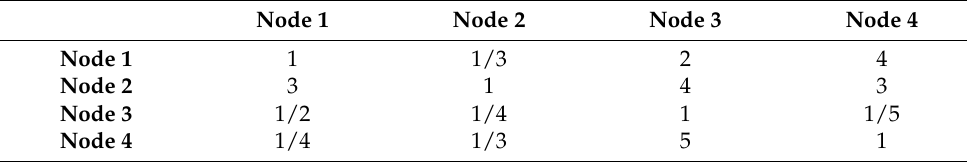
Table A3. Pairwise comparison matrix for No. neighbors criterion.